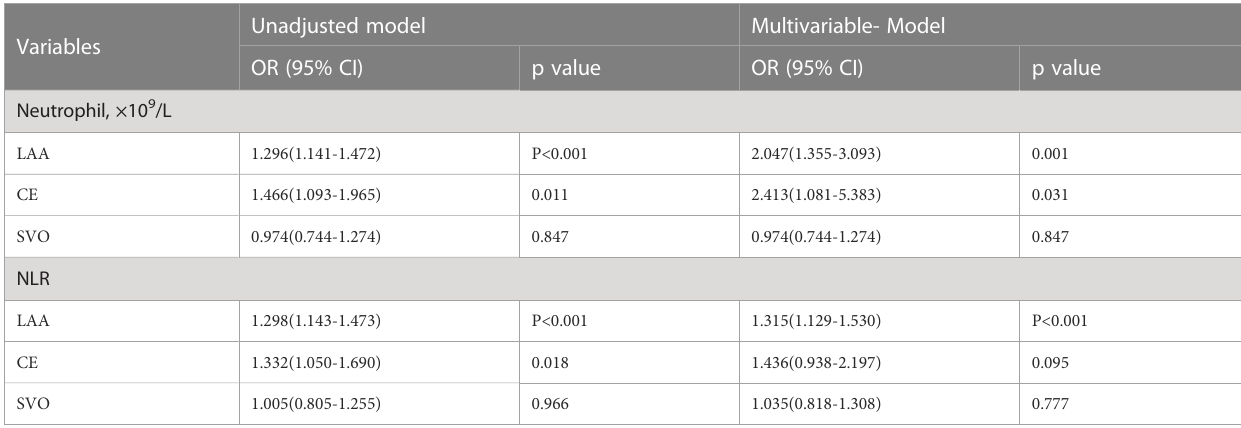
TABLE 3 Unadjusted and adjusted analyses of neutrophil counts and NLR with high SHR group according to TOAST classi fi cation of ischemic stroke etiology.